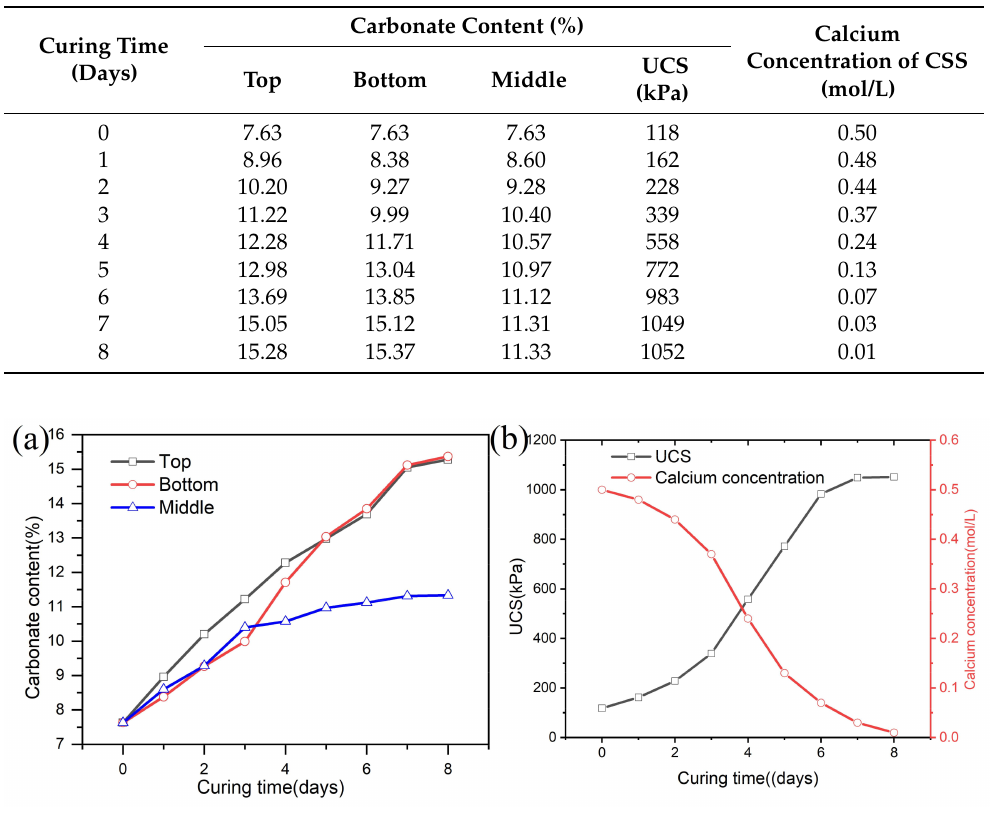
Figure 16. ( a ) The carbonate content, ( b ) the calcium concentration of the calcium source solution (CSS), and the dry UCS at different curing times.